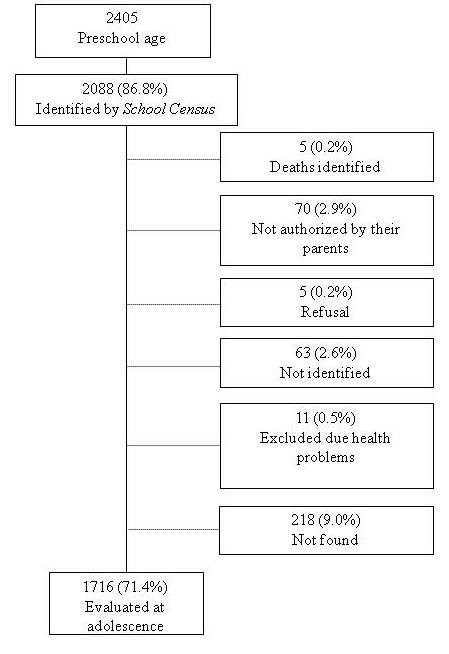
Flow chart of study population.